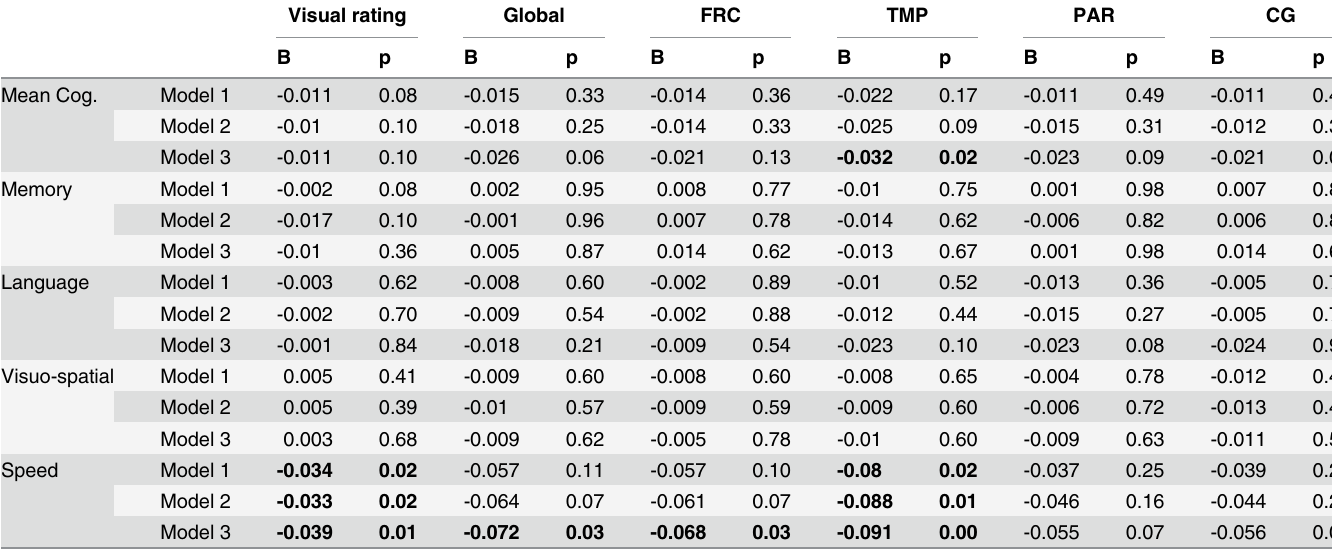
Table 2. Brain A β in relation to the rate of cognitive decline during the decade prior to PET scan among non-demented participants. Visual